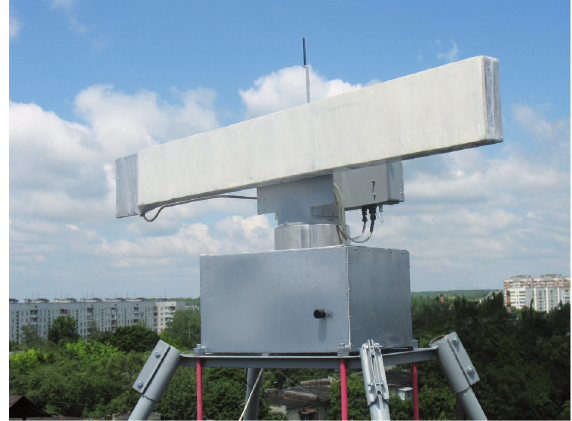
Fig. 1 . A general view of the radar